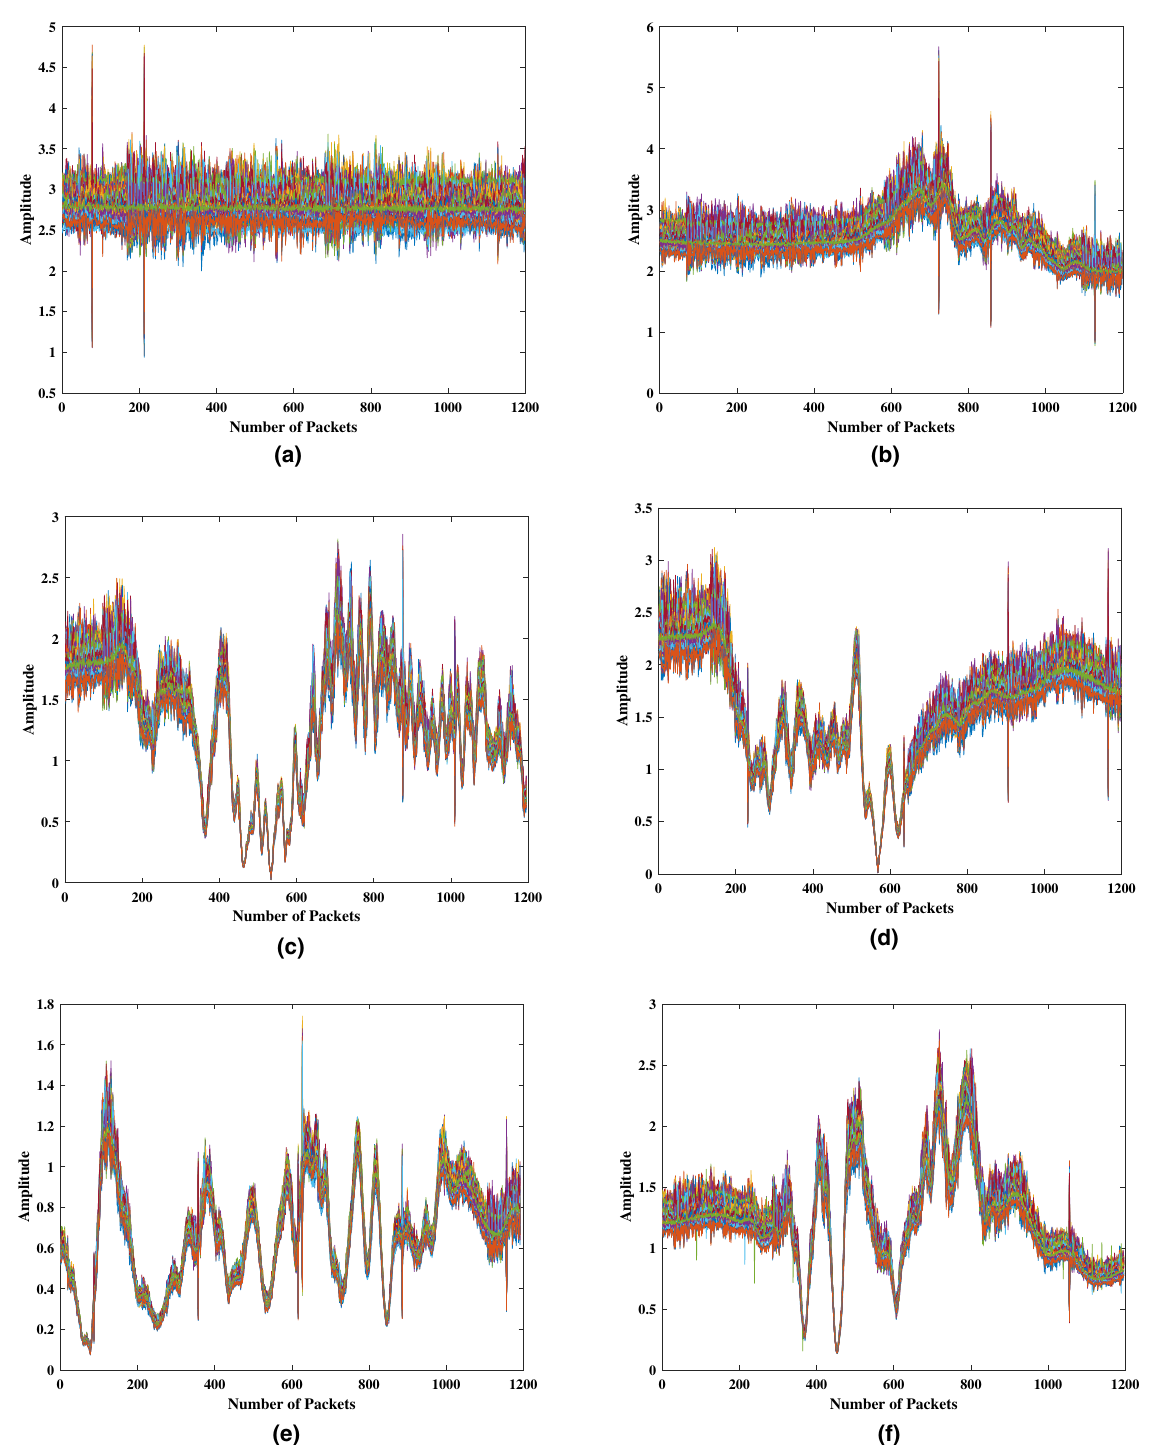
Figure 5. CSI data samples representing various activity classes: ( a ) Empty, ( b ) 1-Subject Sitting, ( c ) 2-Subjects (1 Walking and 1 Sitting), ( d ) 3-Subjects (1 Sitting and 2 Standing), ( e ) 3-Subjects Standing and ( f ) 4-Subjects